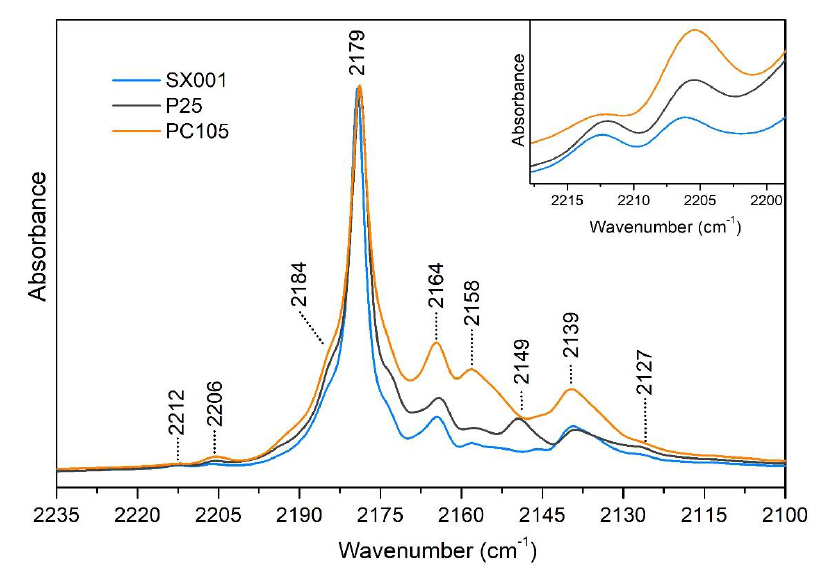
Figure 3. MIR spectra, recorded at 100 K, of CO adsorbed at 25 mbar on SX001 (light blue), P25 (dark grey) and PC105 (orange), previously activated at 873 K. All the spectra have been normalized to the most intense peak at 2179 cm −1 . In the inset a magnification of the signals showing the higher hypsochromic shift in the CO stretching vibration is reported.